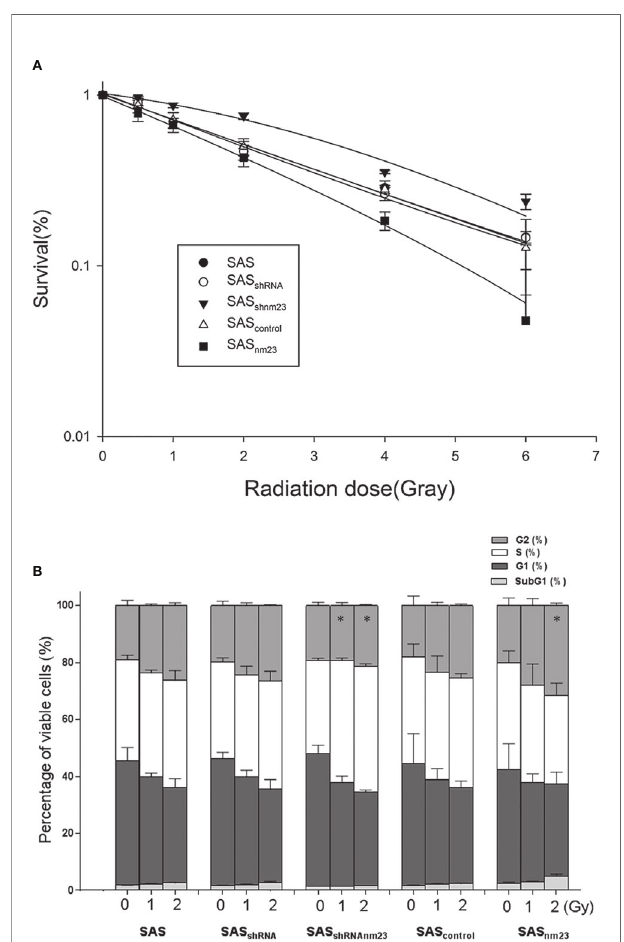
FIGURE 2 | Knockdown of NM23-H1 attenuated the susceptibility of SAS cells to irradiation and decreased the G2/M-phase cell accumulation. (A) Cell viability and radiation survival curves. (B) Cell cycle analysis. Data represent the mean ± standard error of three independent experiments. *p < 0.05 compared with mock controls; statistical signi fi cance was determined using the paired